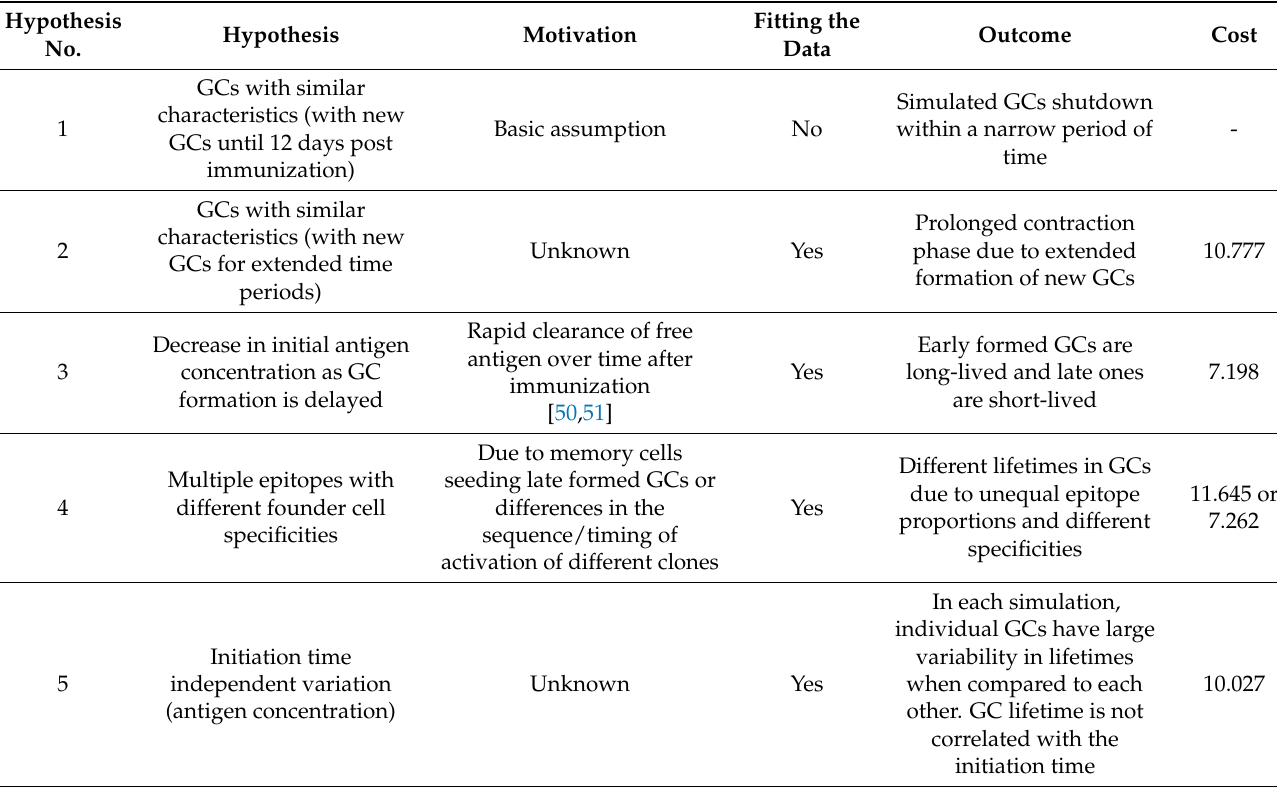
Table 1. Summary of the hypothesis tested, motivation for the assumption and results obtained in fitting Rao data: Cost was calculated with respect to the experimental data on GC volume and number of GCs using Equation (3). Hypothesis